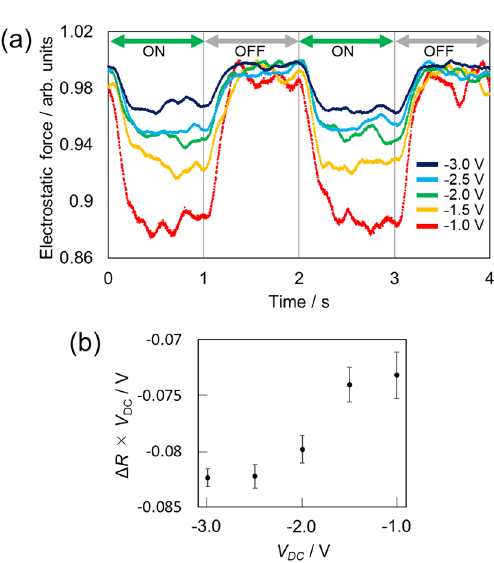
Figure 2. ( a ) Topography and ( b ) contact potential difference (CPD) images of Au NP/TiO 2 . ( c ), ( d ) Cross- sectional views on ( c ) TiO 2 and ( d ) an Au NP for the topography (upper) and CPD image (below) along lines 1 and 2 in ( a ) and ( b ). The intervals for laser irradiation being off and on are shown by the grey and green double arrows, respectively. The points at which the laser irradiation switches from off to on are shown by the gray vertical lines in the cross-sectional views.